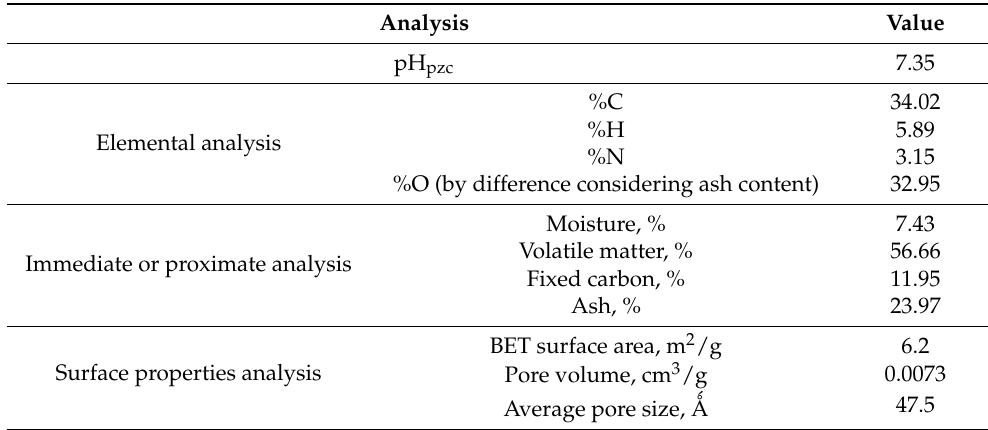
Table 1. Main characteristics of the biosorbent